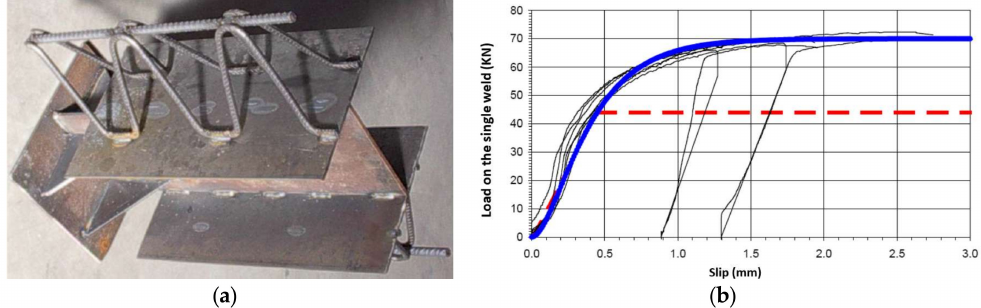
Figure 6. Push-out test by Tullini and Minghini (2013) [7]: ( a ) Lattice before concrete casting for testing employed; ( b ) Load on welding-sliding: —- experimental results; : Ollgaard’s relationship.